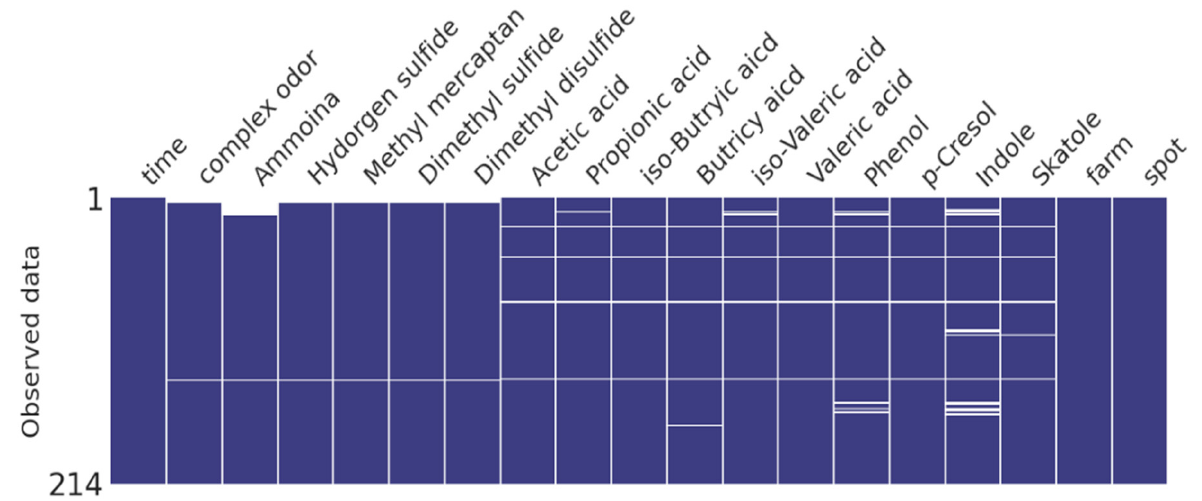
Figure 3. Map of missing data.